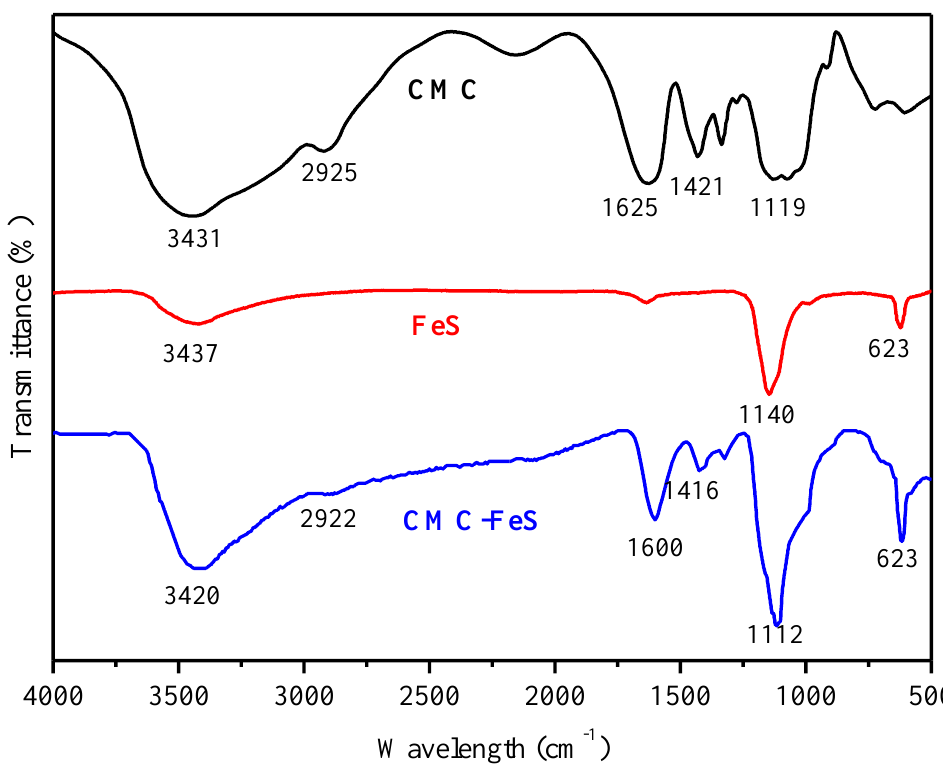
Figure 1. FT-IR spectra of pristine CMC (the black line), non-stabilized FeS (the red line), and CMC-FeS (the blue line). FT-IR spectra elucidate the chemical functional group of the characterized materials.